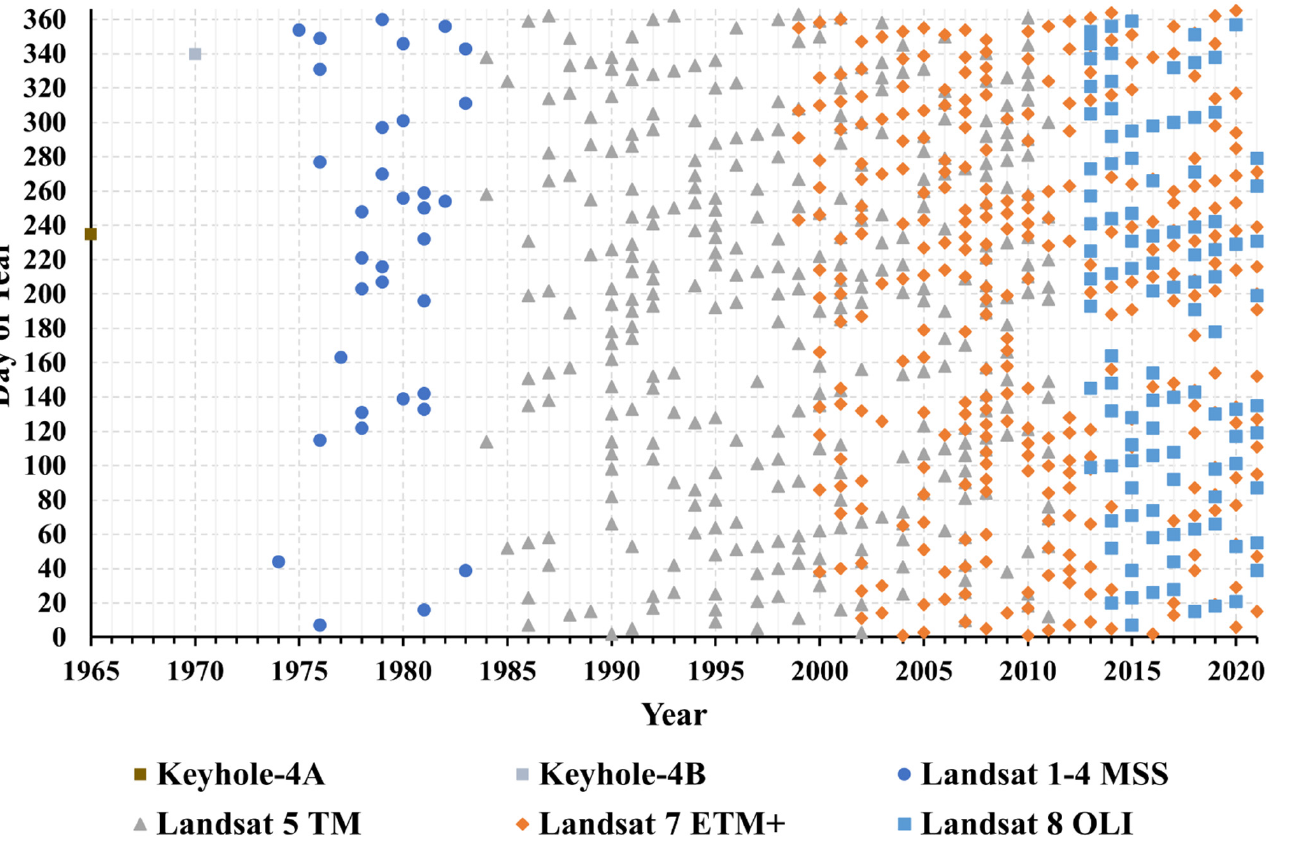
Figure 2. Acquisition dates and sensor types of the satellite images used in this study. The temporal resolution of Keyhole is irregular. As for the Landsat 1–3 and Landsat 4–8 images, the temporal resolution are 18 days, and 16 days, respectively.